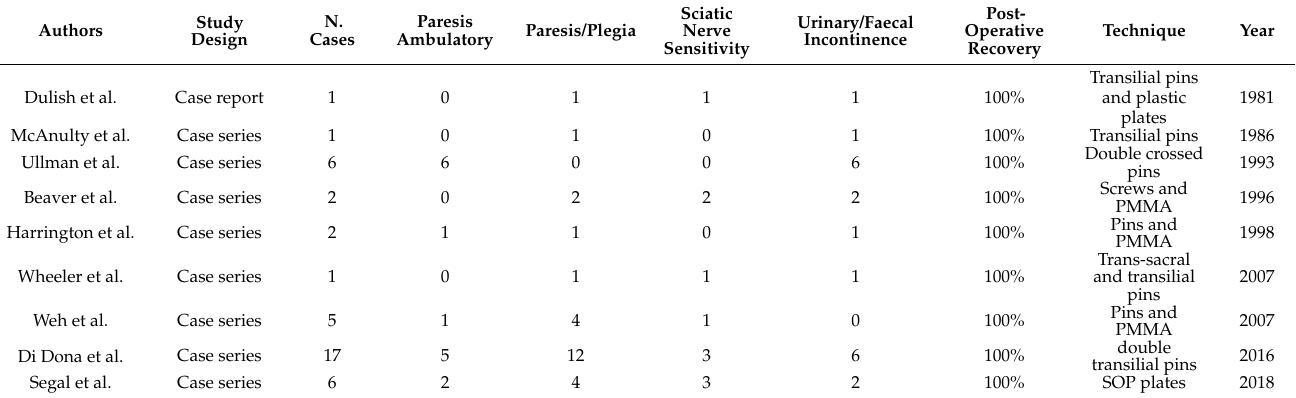
Table 1. List of reviewed papers: Type of paper, clinical presentation, surgical technique, and